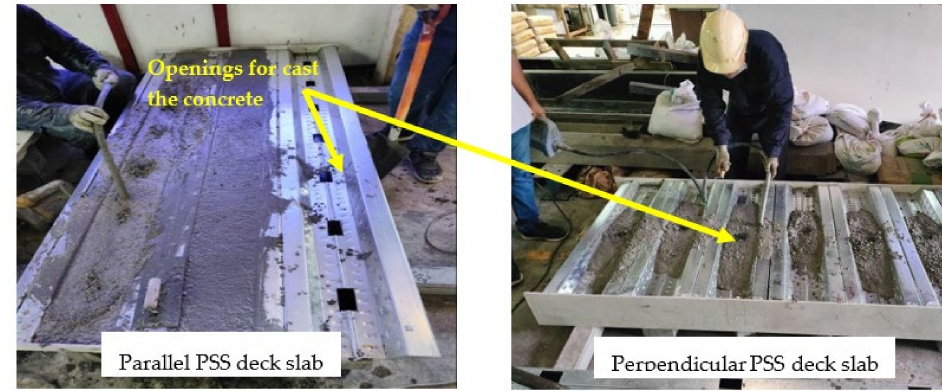
Figure 7. Preparing the CBPDS specimens.